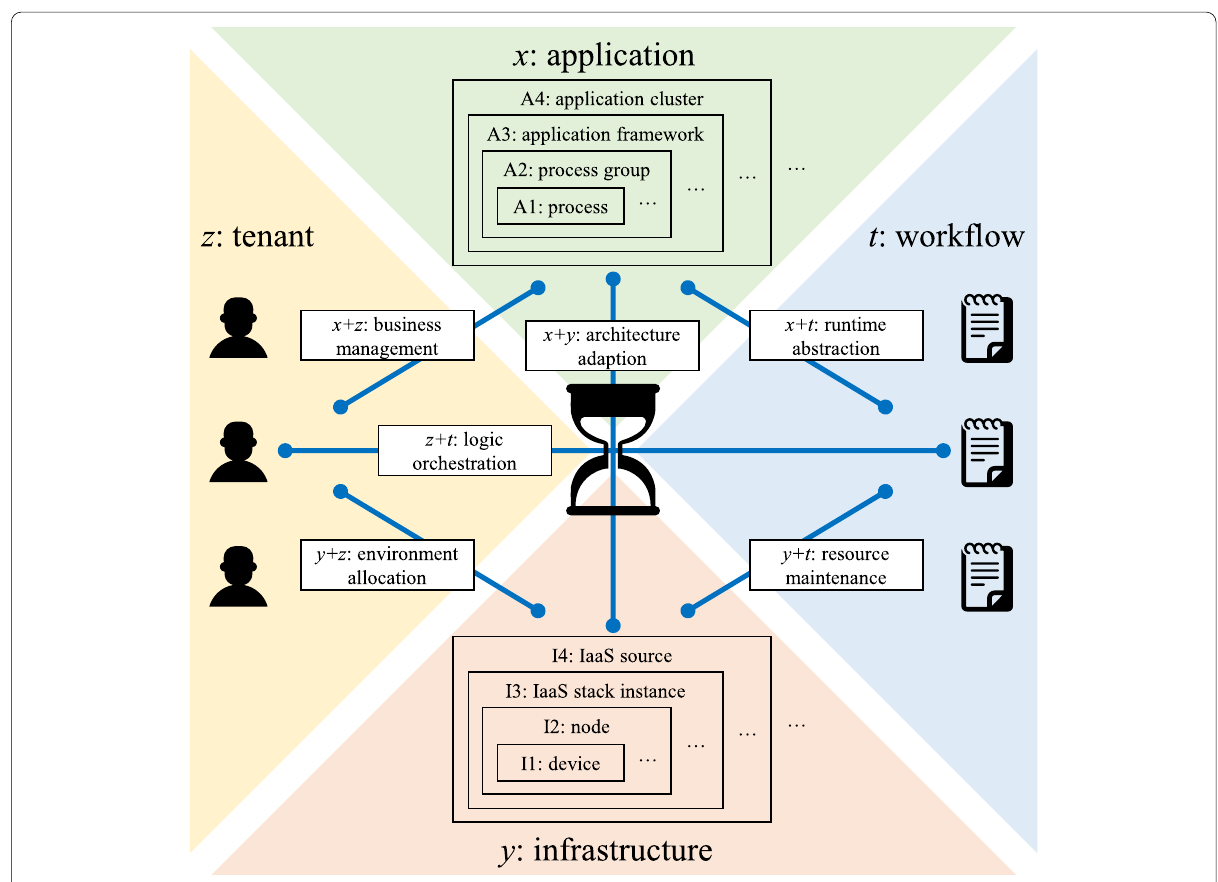
Fig. 2 The composition of the multi-dimensional extensible